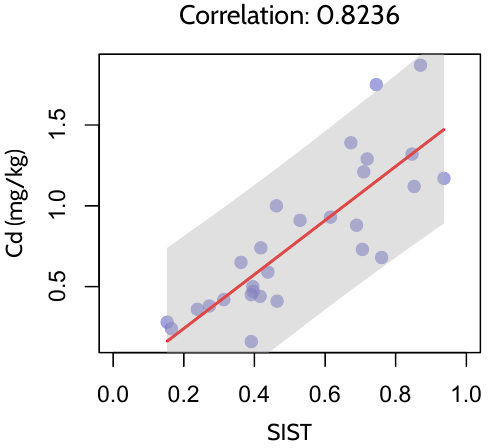
Figure 11. Correlation between SIST and Cd concentrations.